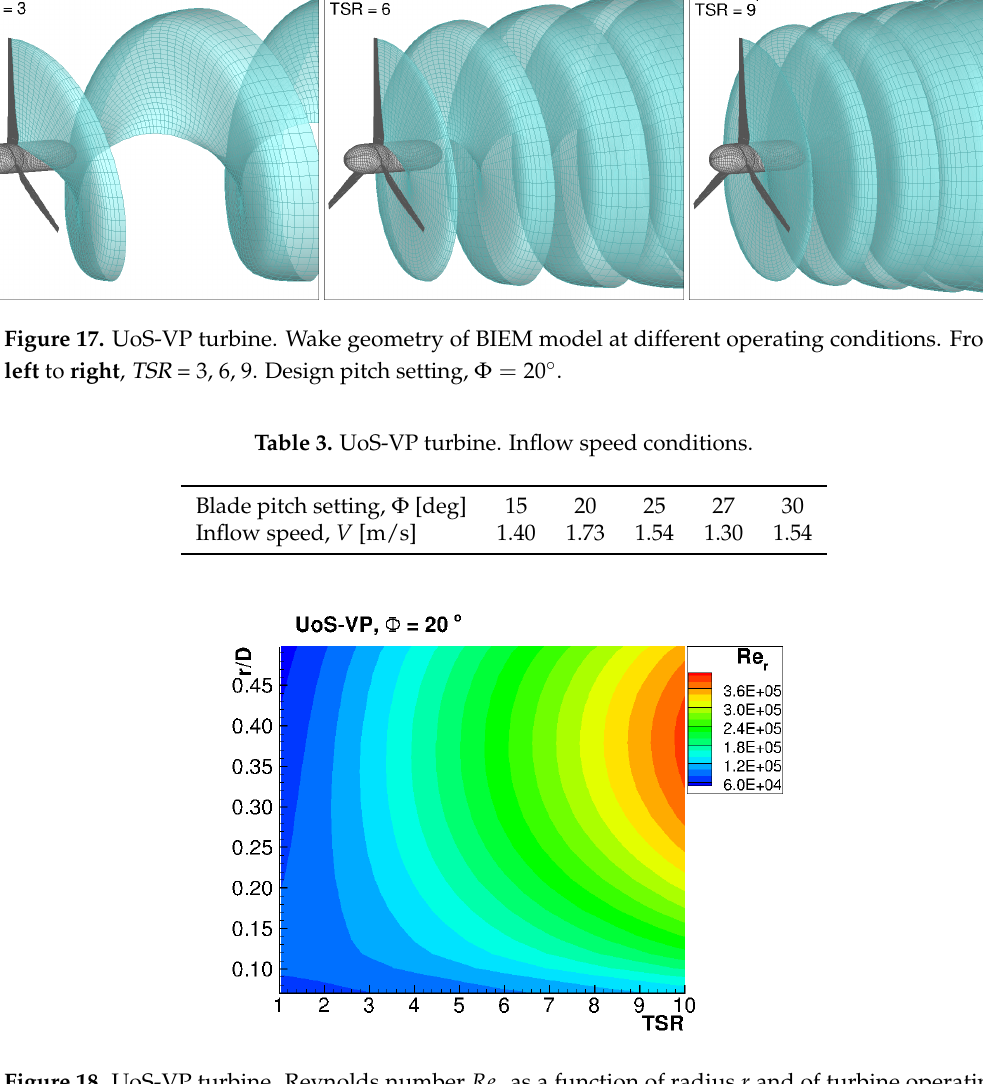
Figure 18. UoS-VP turbine. Reynolds number Re r as a function of radius r and of turbine operating condition ( TSR